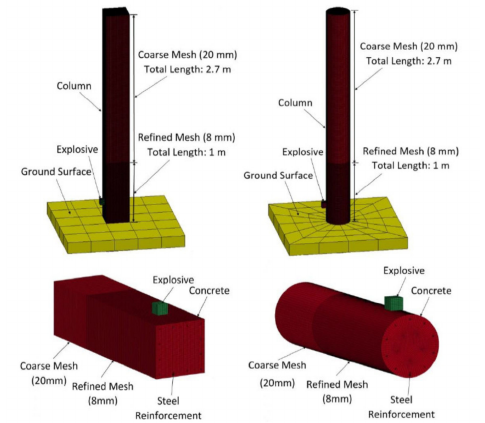
Figure 20. Detailed views of a mesh of 3D column models [23]. Copyright permission obtained from